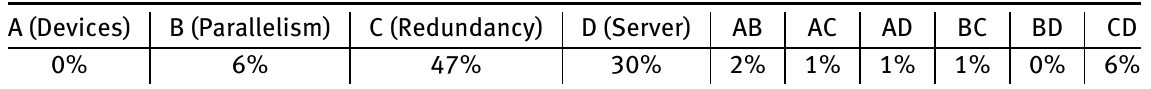
Table 4: Percentage per factor